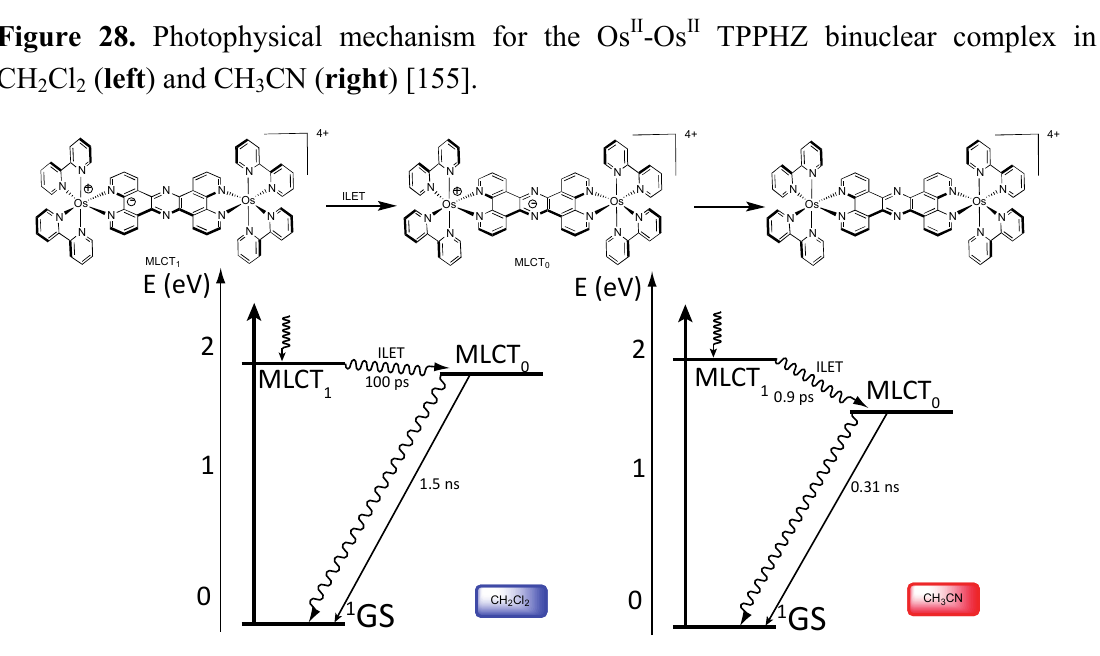
Figure 29. Schematic picture of the charge distribution along the photophysical pathway for the Ru II -Os II TPPHZ binuclear complex in CH